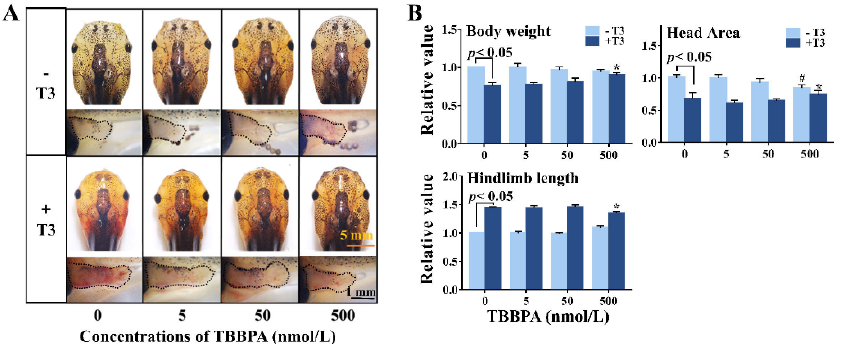
Figure 2. Morphological changes of premetamorphic Xenopus laevis following four-day exposure to tetrabromobisphenol A (TBBPA) in the absence or presence of 1 nmol/L T3. ( A ) Representative morphology of the head and the hindlimb of exposed tadpoles. ( B ) Quantitative analysis for body weight, hindlimb length, and head area of exposed tadpoles. Data are shown as mean ± SD. # indicates significant differences between TBBPA treatment and solvent control treatment ( p < 0.05). * indicates significant differences between TBBPA + T3 treatment and T3 treatment ( p < 0.05).